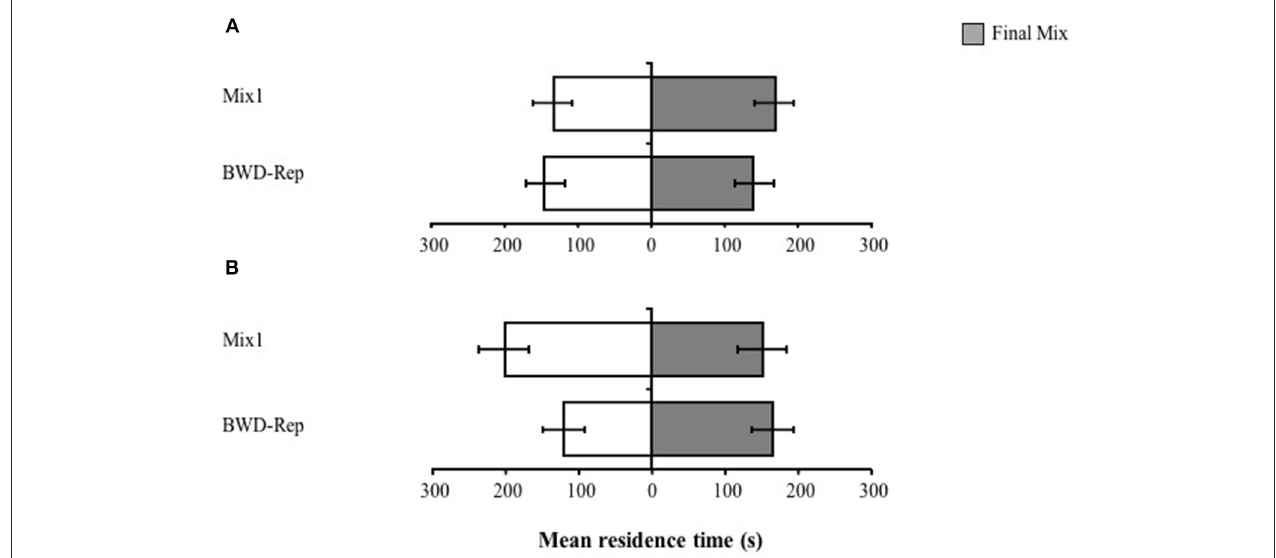
FIGURE 9 | Mean residence time in seconds of male (A) and female (B) boll weevils, Anthonomus grandis , in a Y-tube olfactometer to synthetic blends at the same concentration and ratio as in volatile samples collected from boll weevil-damaged cotton plants at the reproductive stage (for composition of blends, see Table 1 ). BWD-Rep = volatile samples collected from boll weevil-damaged cotton plants at the reproductive stage. Bars indicate standard